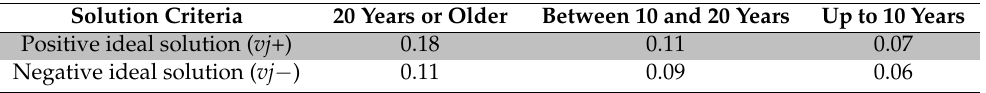
Table 6. Positive ideal solution and negative ideal solution for access to the